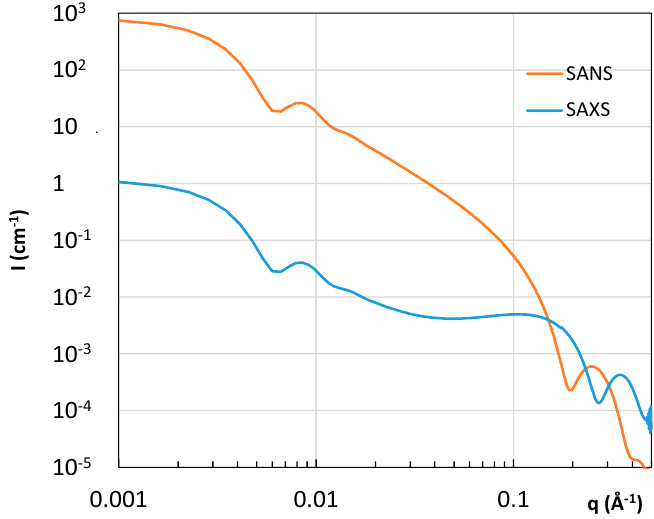
Figure 4. Calculated small-angle X-ray scattering (SAXS) and small-angle neutron scattering (SANS) intensity for a suspension of 1% of liposomes. The SLD profile is shown in Figure 3. R i = 450 Å, t h = 5.4 Å; t c = 28 Å; ρ h , n = 3.5 × 10 10 cm − 2 ; ρ c , n = − 0.208 × 10 10 cm − 2 ; ρ s , n = 6.4 × 10 10 cm − 2 ; ρ h , e = 13.2 × 10 10 cm − 2 ; ρ c , e = 7.6 × 10 10 cm − 2 ; ρ s , e = 9.33 × 10 10 cm − 2 .